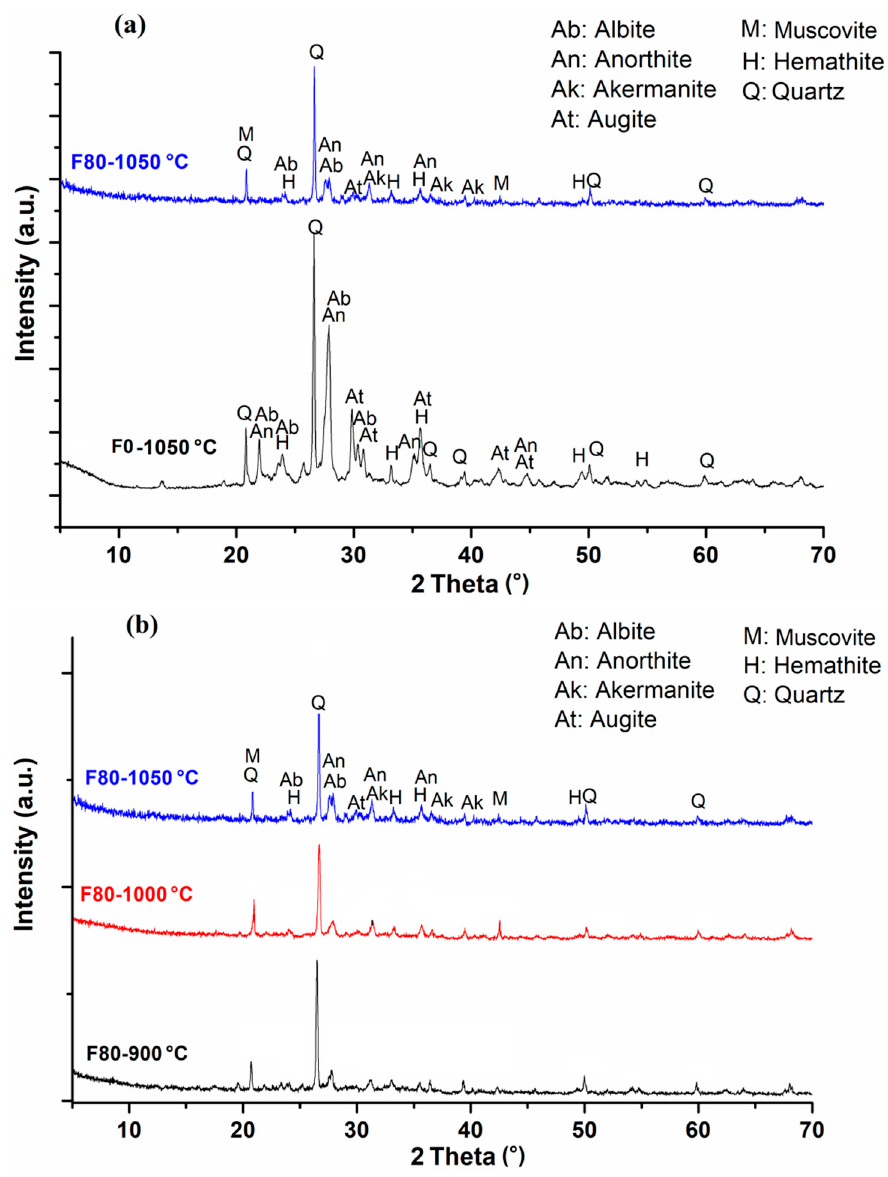
Figure 10. Principal crystalline phases in the ( a ) F0 and F80 mixtures fired at 1050 °C and in the ( b ) F80 mixture fired at different temperatures.